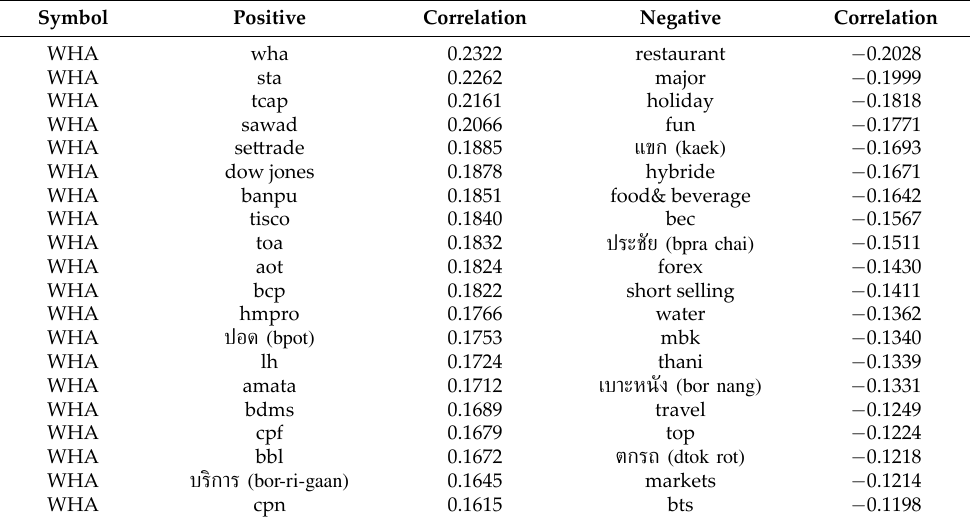
Table 5. Top 20 keywords of WHA Corporation Public Company